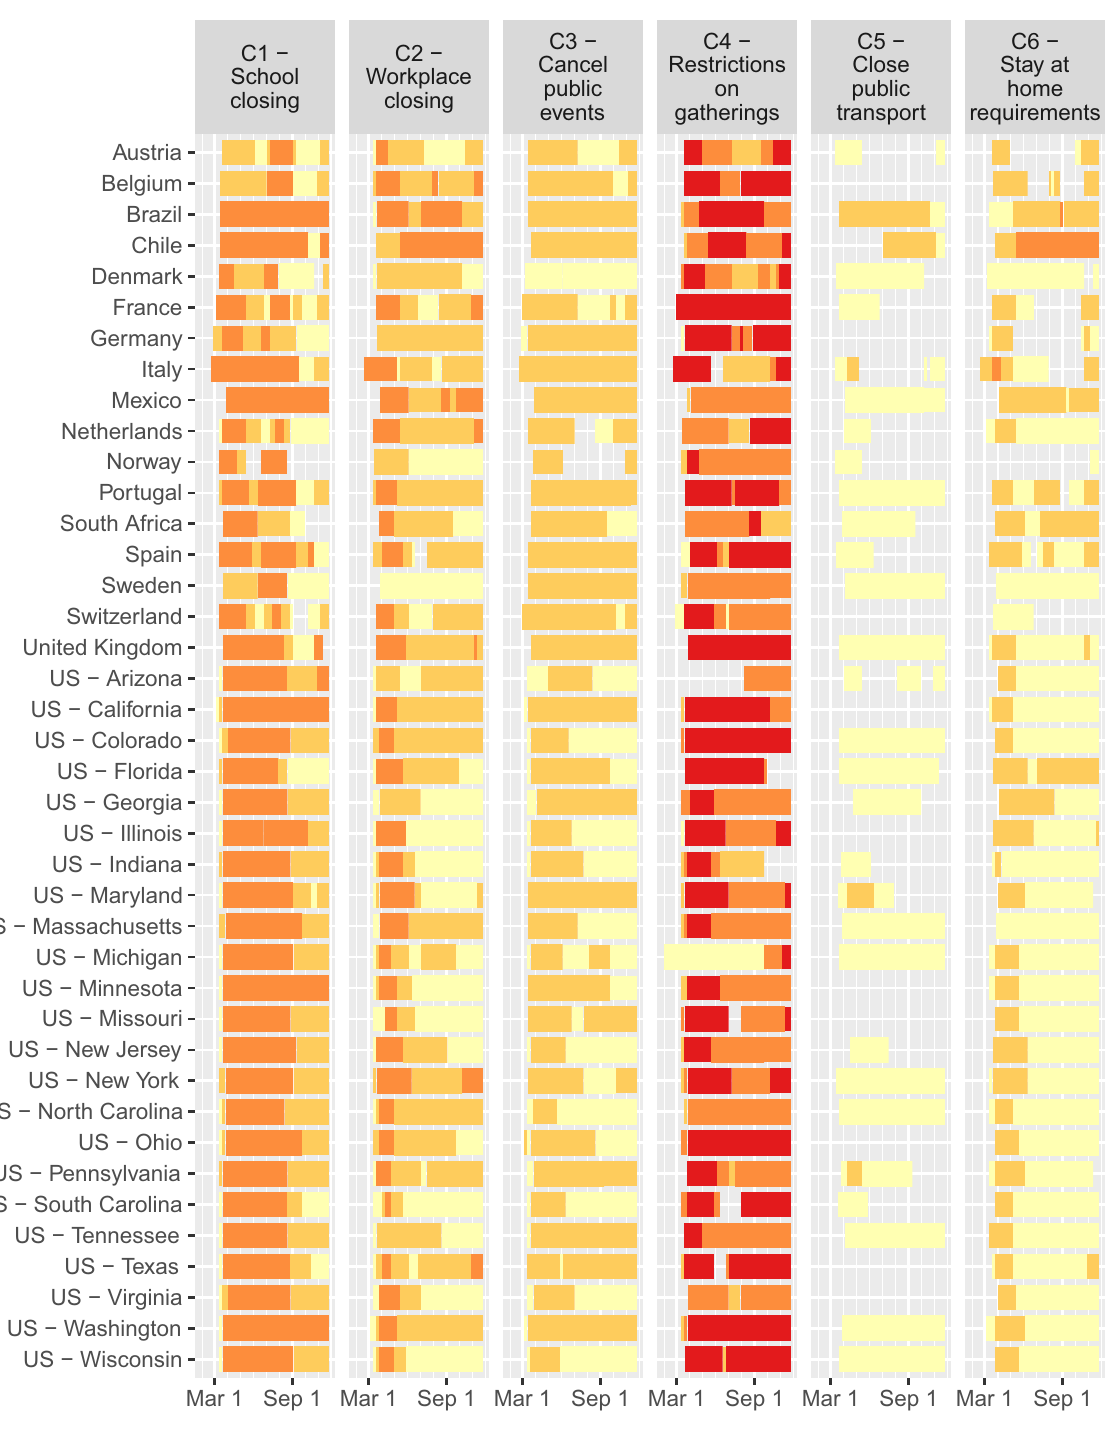
Fig 1. COVID policy levels by week based on OxCGRT database. Policies C1-C6; continued in Fig 2.